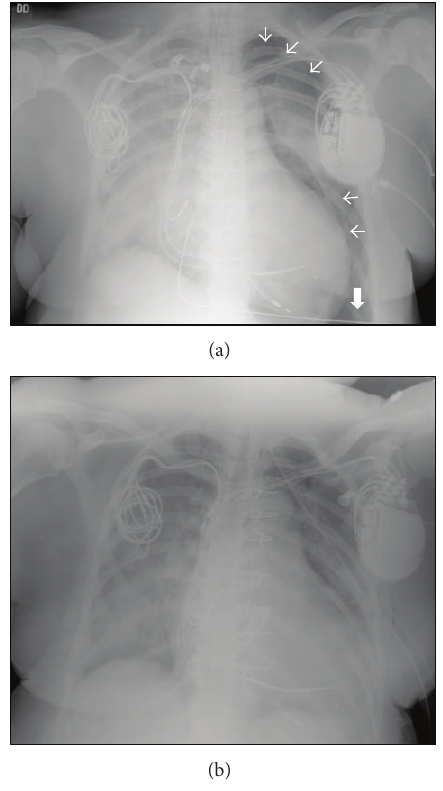
Figure 2: (a) Initial chest radiograph immediately following intuba- tion revealing a large left-sided pneumothorax. Small arrows show the outline of the pneumothorax, partially obscured by the ICD. The large arrow shows depression of the left hemidiaphragm, which is a sign of tension pneumothorax. (b) Resolution of the pneumothorax after prompt chest tube